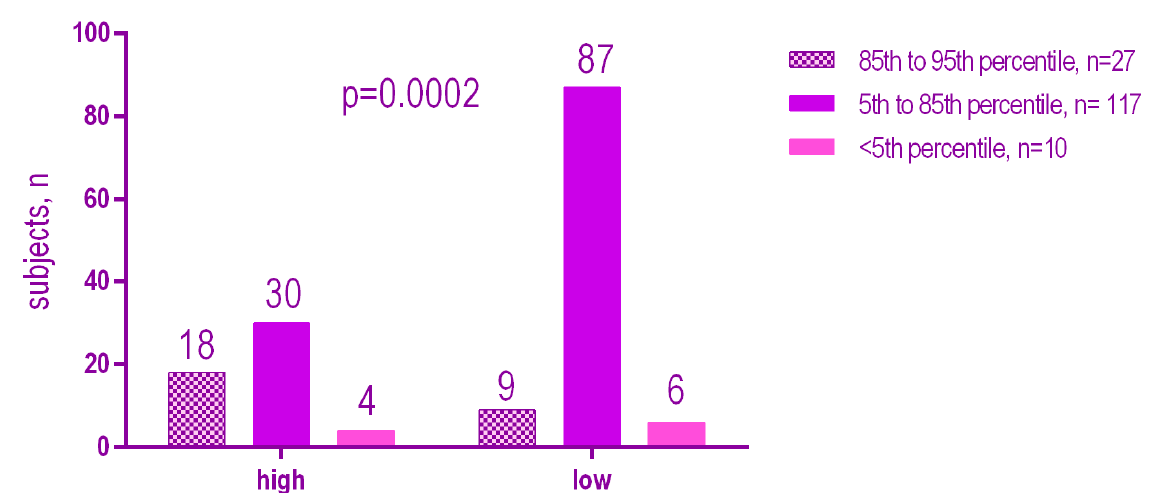
Figure 7. Mutans Streptococci levels according to the BMI.